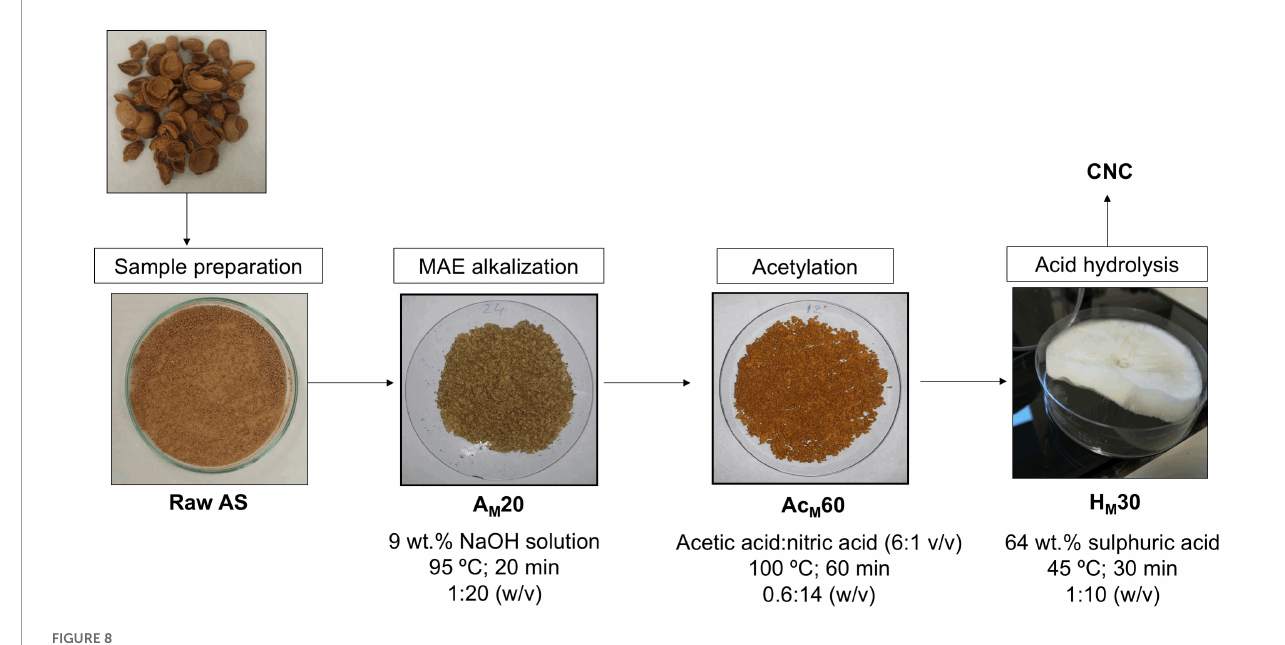
FIGURE8 Scheme of CNCs’ isolation from AS using the MAE-based procedure.